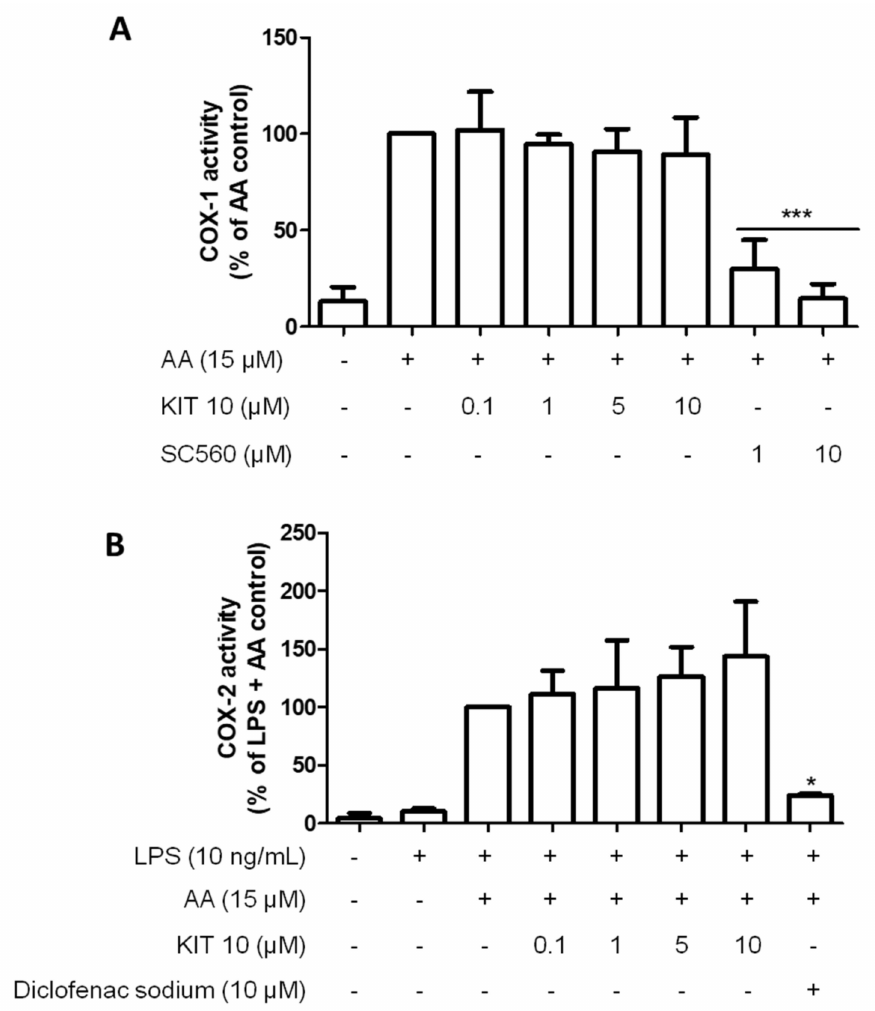
Figure 4. KIT 10 did not affect COX enzymatic activities. ( A ) To assess COX-1 activity, cells were treated with different concentrations of KIT 10 (0.1–10 µ M) for 15 min before the addition of 15 µ M of arachidonic acid (AA). PGE 2 in the supernatants was measured after an additional 15 min. ( B ) To assess COX-2 activity, cells were stimulated for 24 h with LPS (10 ng/mL) and then treated with different concentrations of KIT 10 for 15 min. After this incubation time, 15 µ M of AA were added and PGE 2 in the supernatants was measured by enzyme immune assay. Data are expressed as mean ± SEM of at least three new cultures/group. * p < 0.05 and *** p < 0.001 with respect to control (One-way ANOVA followed by the Newman-Keuls